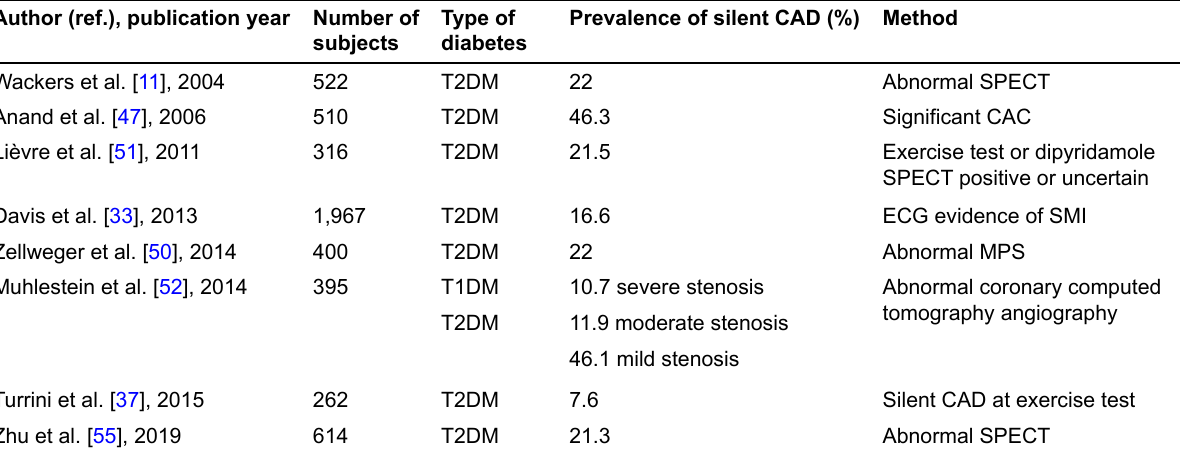
Table 2. Prevalence of silent CAD among diabetic subjects, observed in major studies Author (ref.), publication year Number